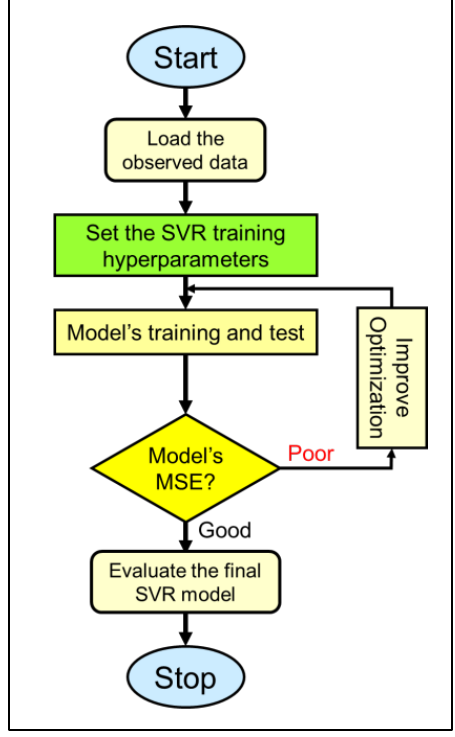
Figure 6. SVR flow